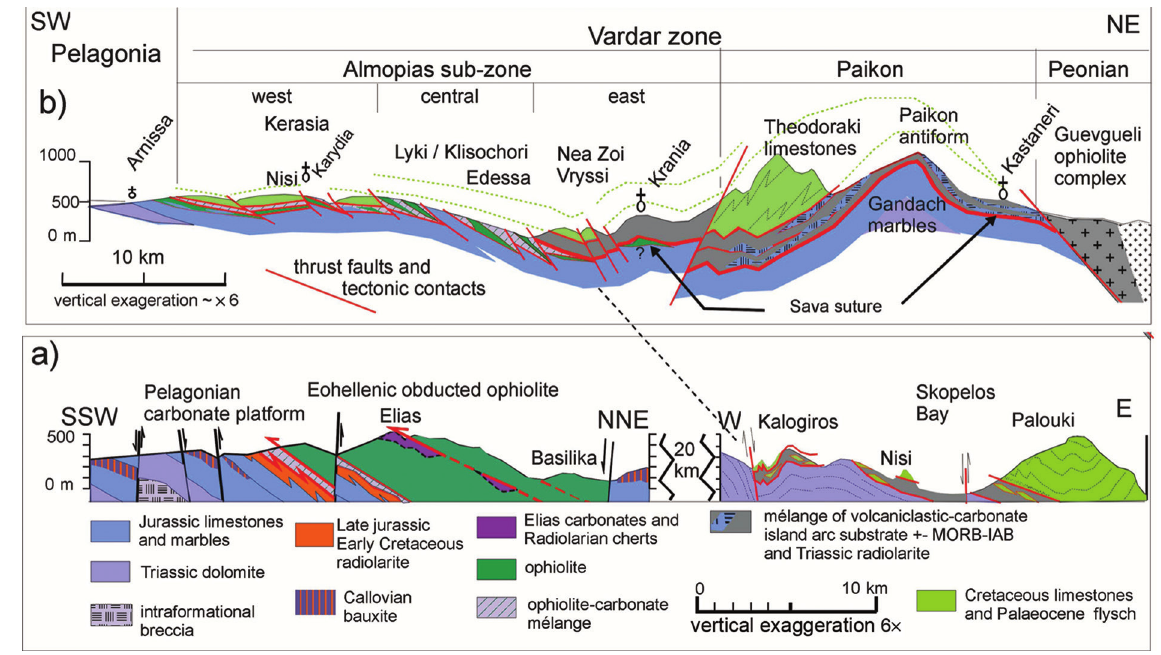
Overview tectonic sections of the study areas (nomenclature ‘Almopias, Paikon and Peonian’ units after Kockel